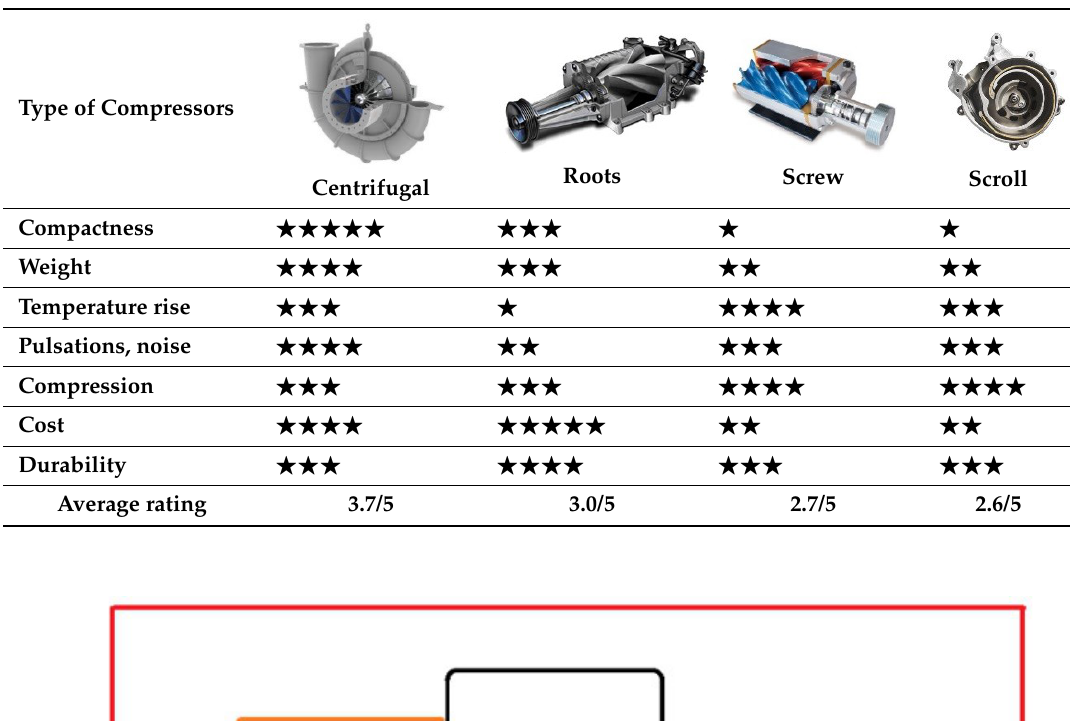
Table 2. Comparison of centrifugal, roots, screw, and scroll compressors [24–28]. (cid:70) : very bad; (cid:70)(cid:70) :